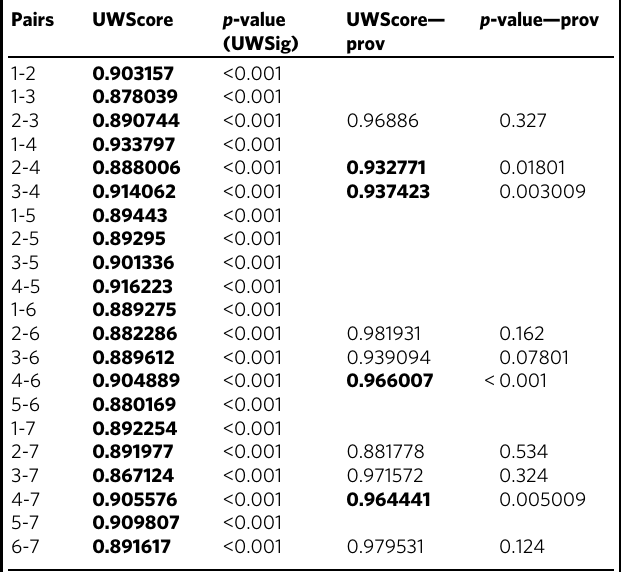
Table 1 Microbial phylogenetic signal in the modularity of the sponge core – microbiome network Pairs